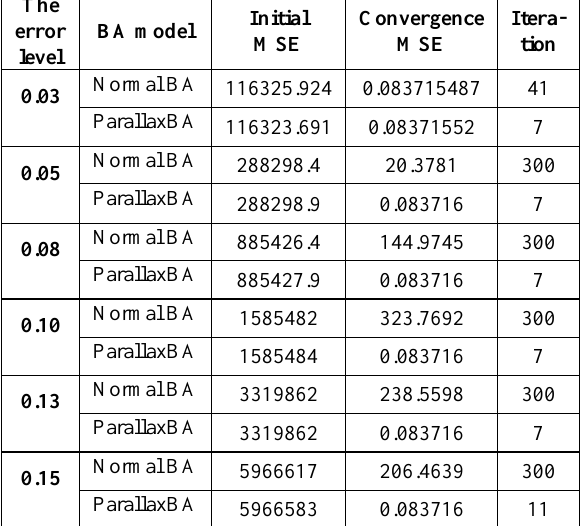
Table 2. The convergence of the ParallaxBA model and the normal BA model given different initial values of camera angle elements